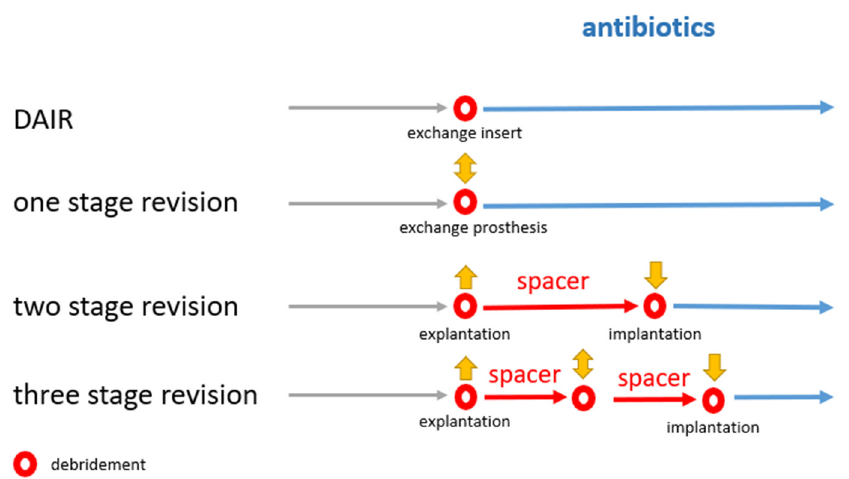
Figure 2. Overview of surgical procedures in case of periprosthetic joint infection as the reason for revision. DAIR = debridement, antibiotics and implant retention.